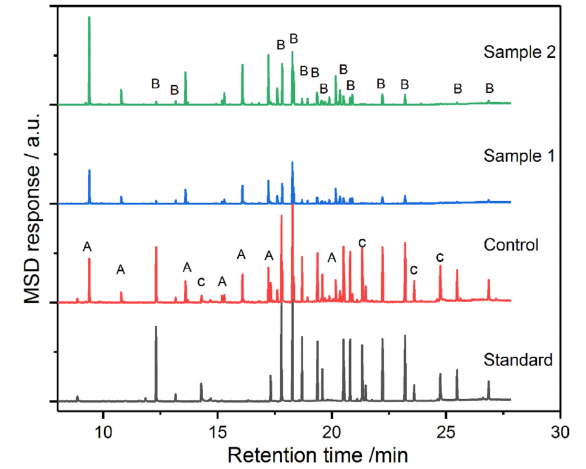
Figure 12. The chromatograms of organophosphorus pesticides under di ff erent conditions (sample 1: TMS-mNP55 and Sample 2: TMS-mNP100). Table 6. The extracted concentrations of the organophosphorus pesticides by using TMS grafted mNPs: TMS-mNP55 and TMS-mNP100 from 1.5 mL contaminated samples. R t